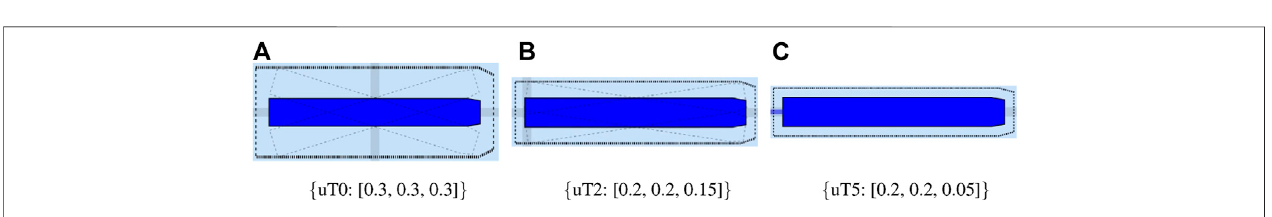
Frontiers in Robotics and AI |